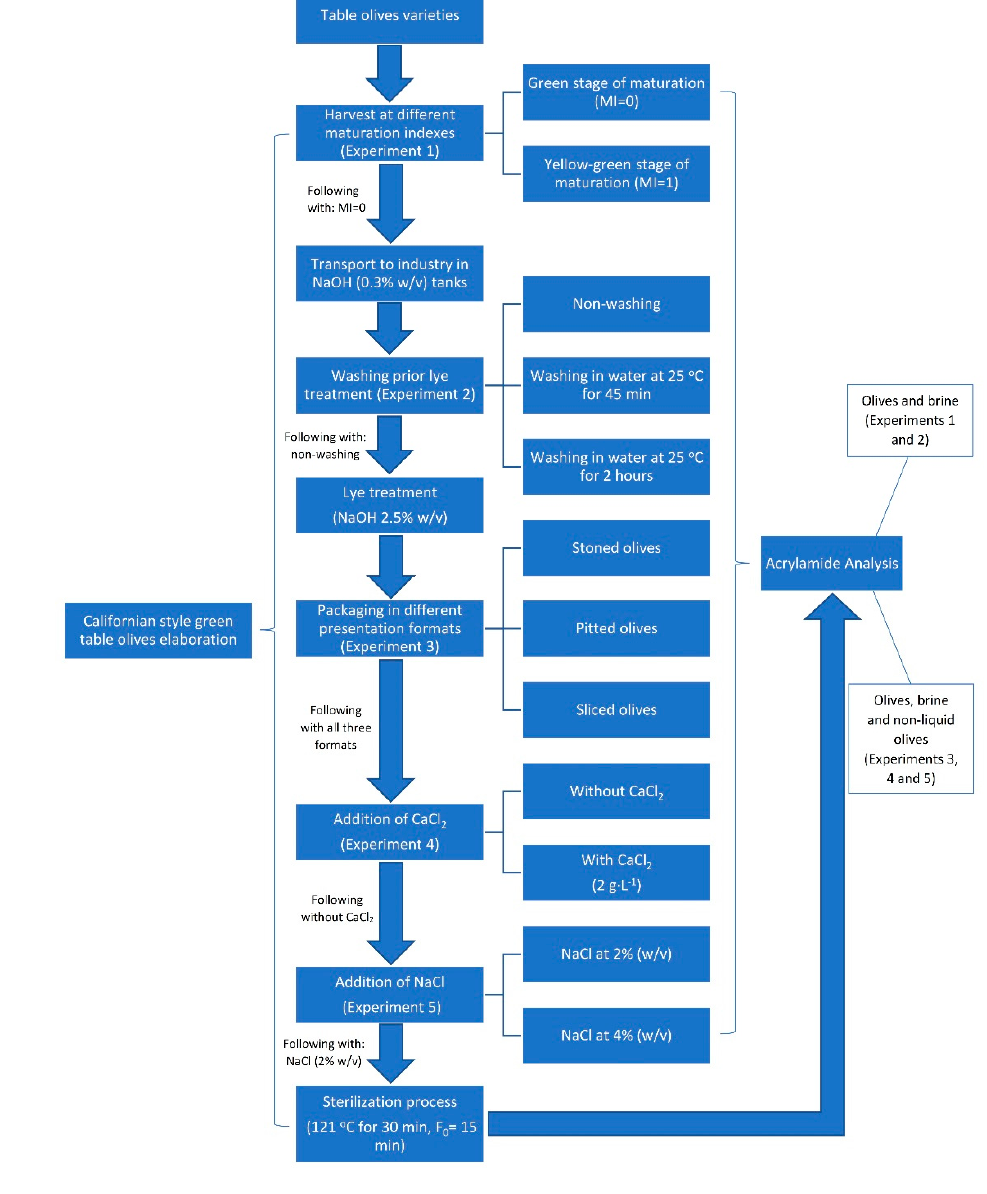
Figure 1. Diagram of the experimental design.